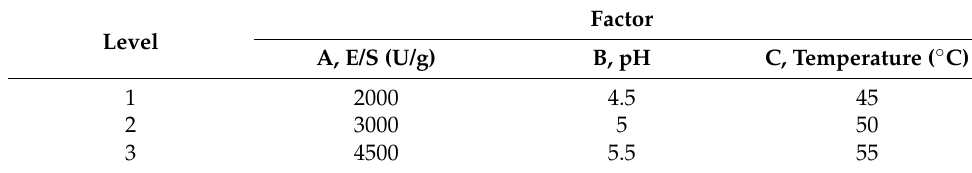
Table 1. L 9 (3 4 ) orthogonal array design for papain hydrolysis.